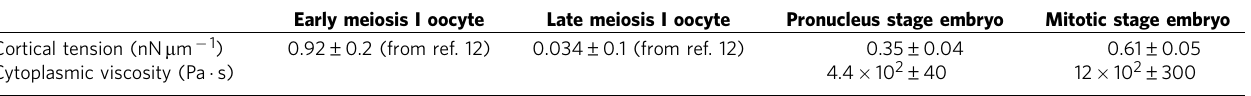
Table 1 | Cortical tension and viscosity in oocytes and embryos. Early meiosis I oocyte Late meiosis I oocyte Pronucleus stage embryo Mitotic stage embryo Cortical tension (nN m m (cid:2) 1 ) For cortical tension in embryos, mean of 13 Pronucleus stage and 9 mitotic embryos is shown, measured over 8 independent experiments. The statistical significance of differences is assessed with a t -test ( P value 0.0011). The values of cortical tension for early and late oocytes are extracted from ref. 12. For cytoplasmic viscosity, mean of 16 Pronucleus stage and 15 mitotic embryos is shown, measured over 6 independent experiments. Statistical significance of differences is assessed with a Mann–Whitney test ( P value o